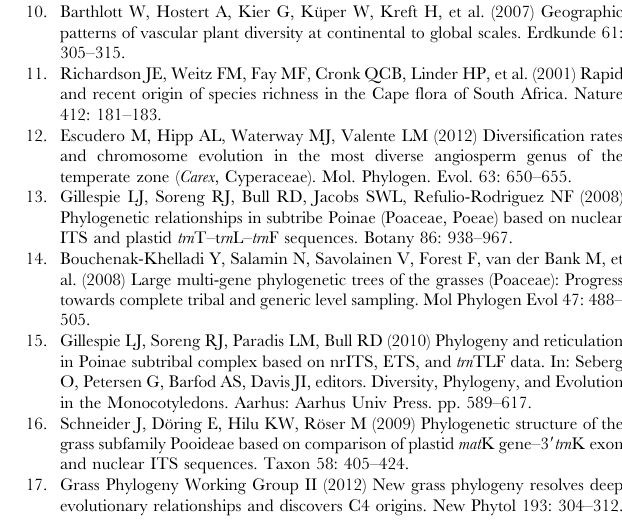
Figure S1 Complete phylogenetic tree of all ITS se- quences used in this study. The colors are as in figure 1, the numbers above the branches are bootstrap support values . 50%. The original taxon names as recorded in GenBank were used.